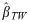
Two-way FE estimates with almost-fixed within-case and within-time slopes.The value of β^TW is equal to the coefficient on x obtained from a two-way FE linear regression of the simulated data. The standard deviation of the β^TW estimates is calculated from 100 random replicates for the given values of the standard deviation of the within-case and within-time slopes along the x and y axis.